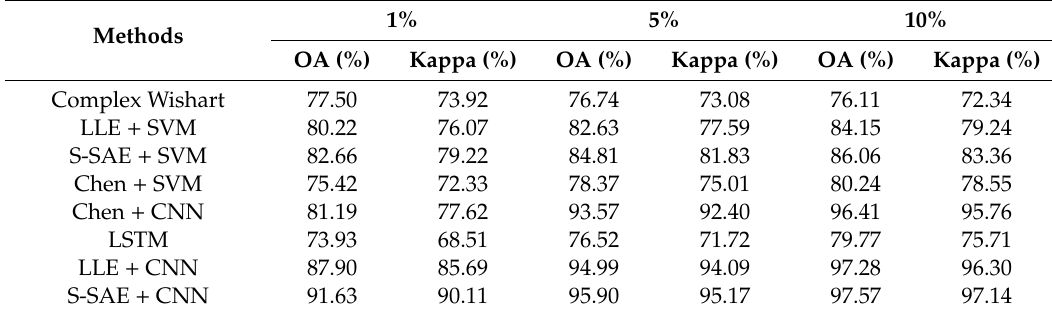
Table 10. Classification accuracy with the di ff erent methods and training ratios for the Flevoland